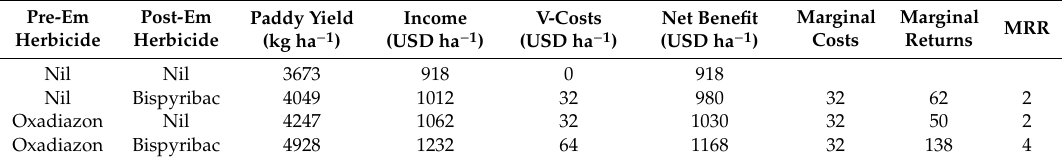
Table 10. Marginal rates of return (MRR) for increasing seeding rates vs. herbicide for weed suppression in